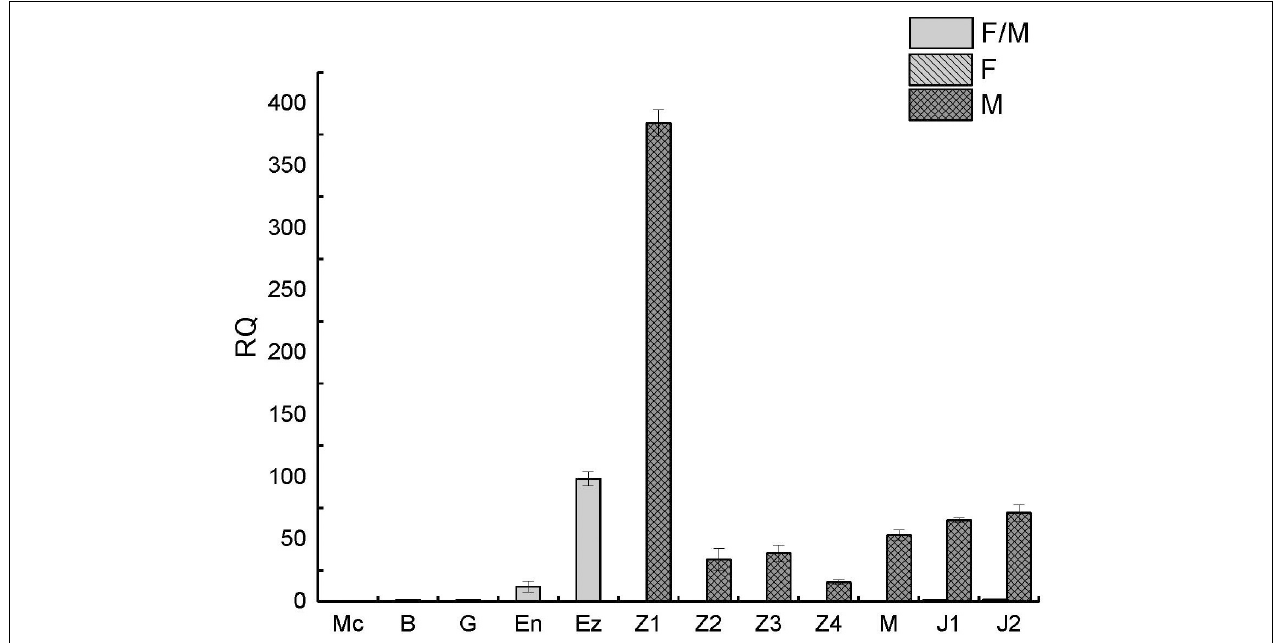
FIGURE 6 | qRT-PCR of PtDMY at different developmental stages. Fertilized egg (Multicellular stage, Mc; Blastula stage, B; Gastrulation stage, G; Egg-nauplius stage, En; Egg-zoea stage, Ez), Zoea (Zoea 1, Z1; Zoea 2, Z2; Zoea 3, Z3; Zoea 4, Z4), Megalopa (M), and Juvenile crab (Juvenile crab 1, J1; Juvenile crab 2, J2).